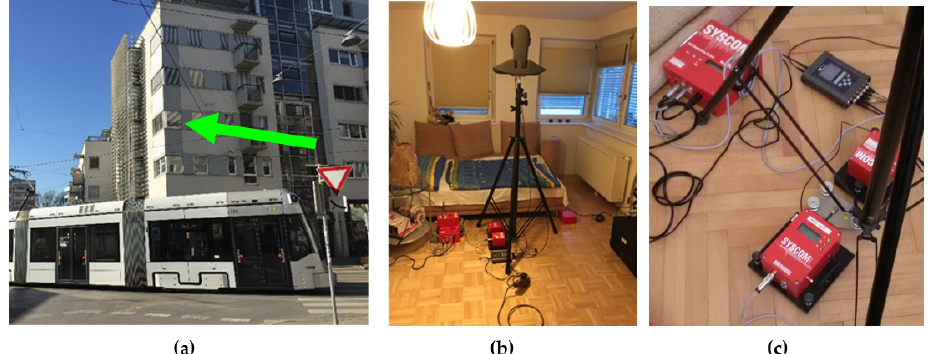
Figure 3. Measuring Point 5, flat, 2nd floor: ( a ) outside view facing tramway rails; and ( b ) measurement setup in the living room.